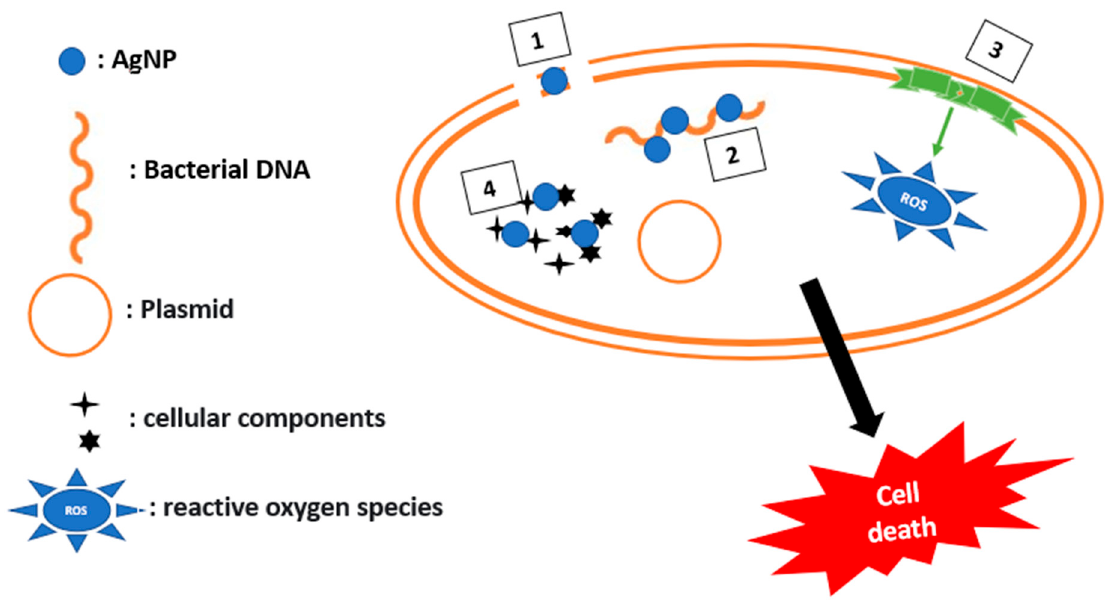
Figure 7. Mechanisms to alter bacterial physiology by using AgNPs. (1) Membrane permeabilization, (2) Interaction with DNA, (3) Liberation of ROS, (4) Interaction with cellular